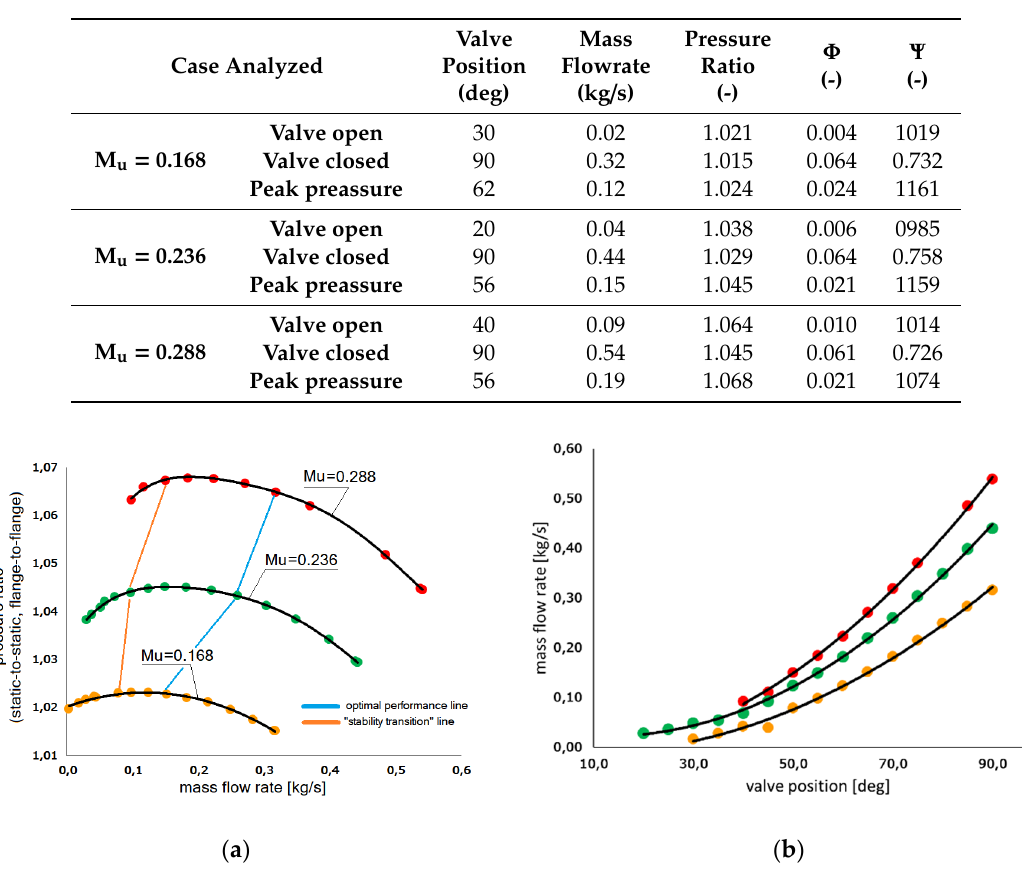
Table 3. Summary of main observations regarding the unstable flow structures appearing at different rotational speeds (MOA—The moment of appearance).